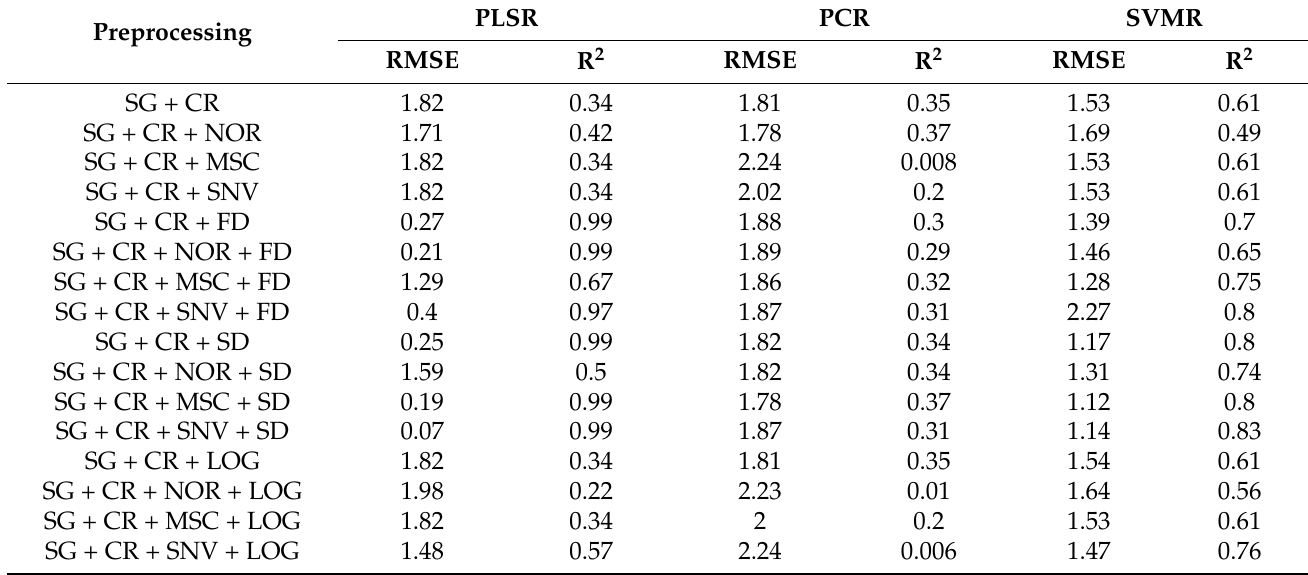
Table 4. Determination accuracies of Ni concentrations based on Vis–NIR spectral bands.